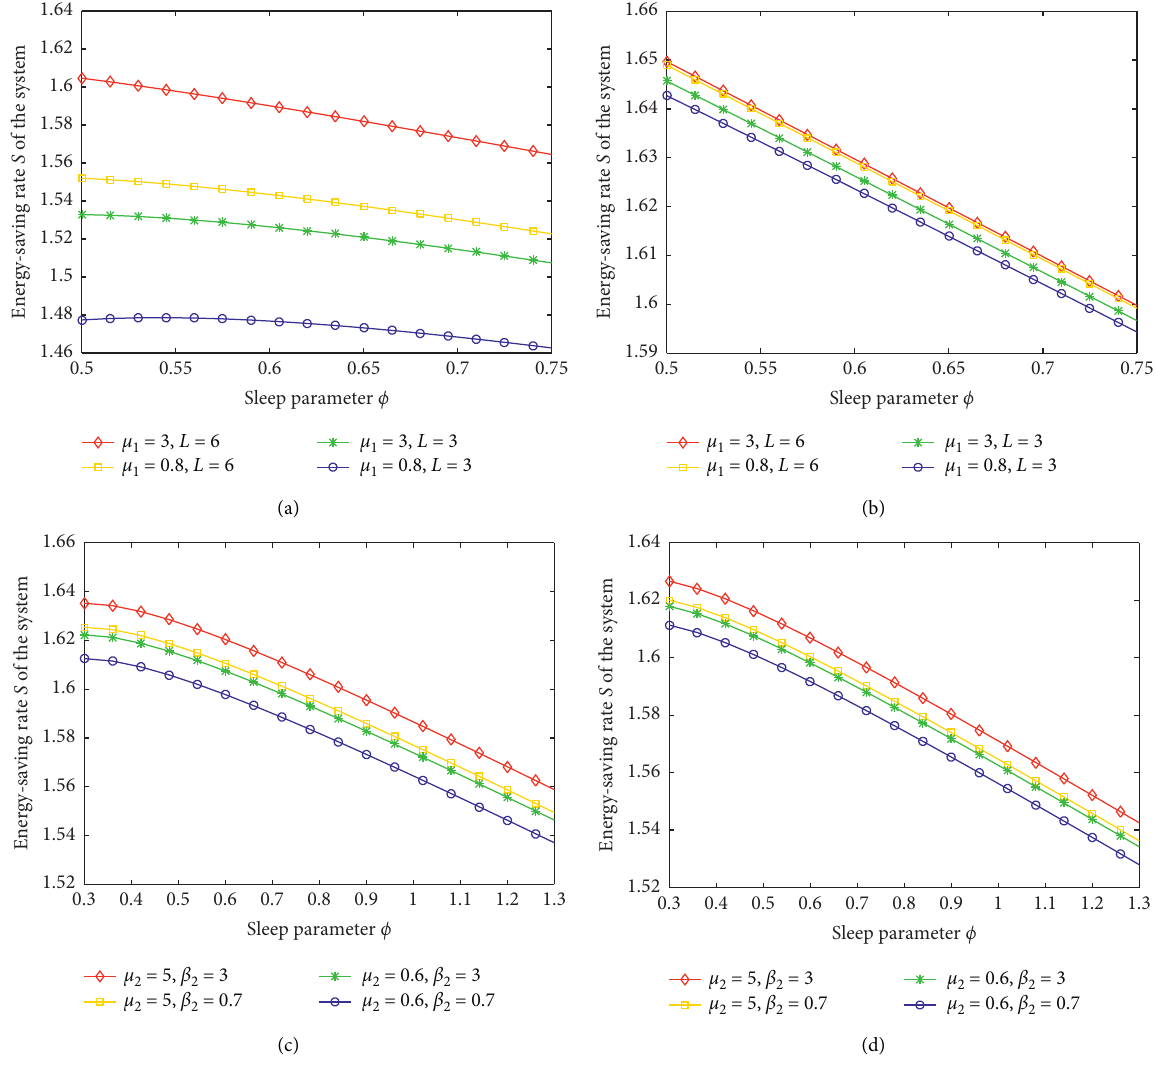
Figure 3: Energy-saving rate S of the system vs. sleep parameter ϕ . (a) n n � 4 , n � h w